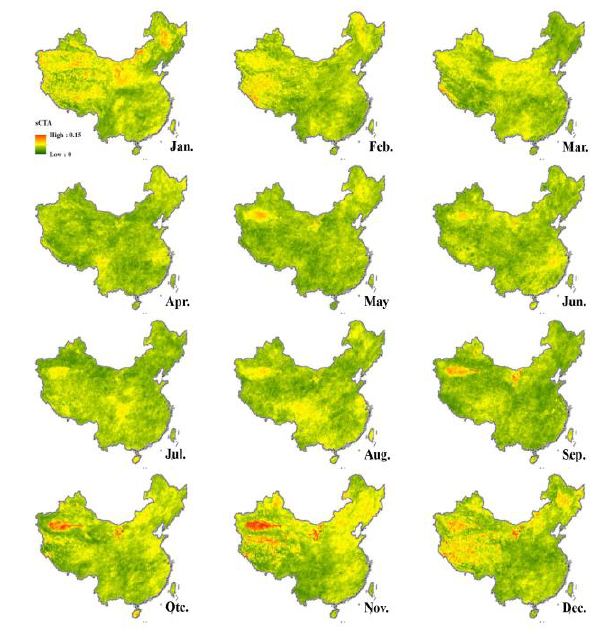
Figure 5. The standard deviation of cloud total amount in China in different months The window period of cloudless images acquisition is the months in which both the averaged cloud total amount and the standard deviation are small. According to the spatial distribution and the standard deviation of cloud total amount in China, the window period of cloudless images acquisition was determined (Table 2). It also can be seen that the cloud total amount is relatively higher in winter than that in other months. The reason might be misclassification of snow as cloud in these areas in winter.